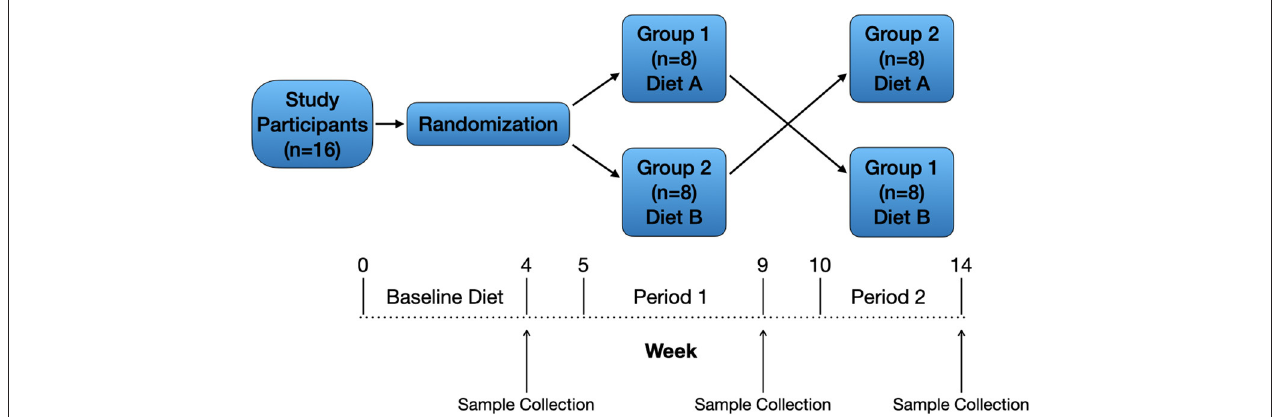
FIGURE 2 | Study design. Sixteen healthy adult dogs were included and received a baseline diet for ≥ 4 weeks. After randomization, dogs assigned to group 1 ( n = 8) remained on the baseline (traditional) diet (A) during period 1, and dogs assigned to group 2 ( n = 8) were gradually transitioned from the baseline diet to the PBD (B) over 1 week. After 4 weeks on the assigned diets, dogs were fasted for 12h then underwent physical examination and blood collection. Both groups of dogs underwent a 1-week transition period to the alternative diet (A to B, B to A) followed by 4 weeks on the assigned diet then final physical examination and blood